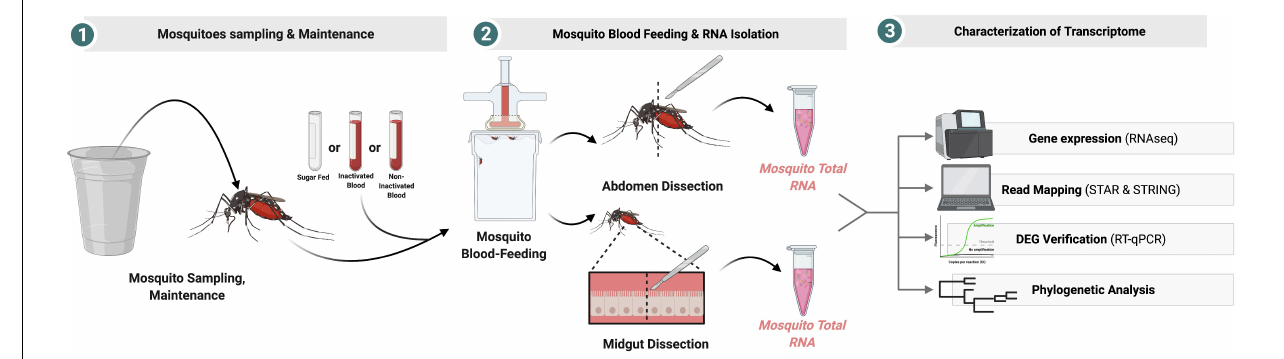
FIGURE 11 | Graphic summary of the experimental